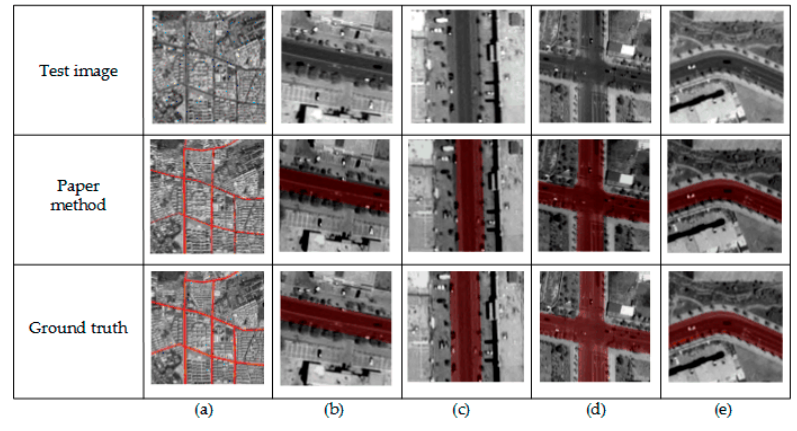
Figure 17. E ff ect picture of Experiment 3 and its local enlarged view ( a – e Figure 17. Effect picture of Experiment 3 and its local enlarged view ( a–e ).